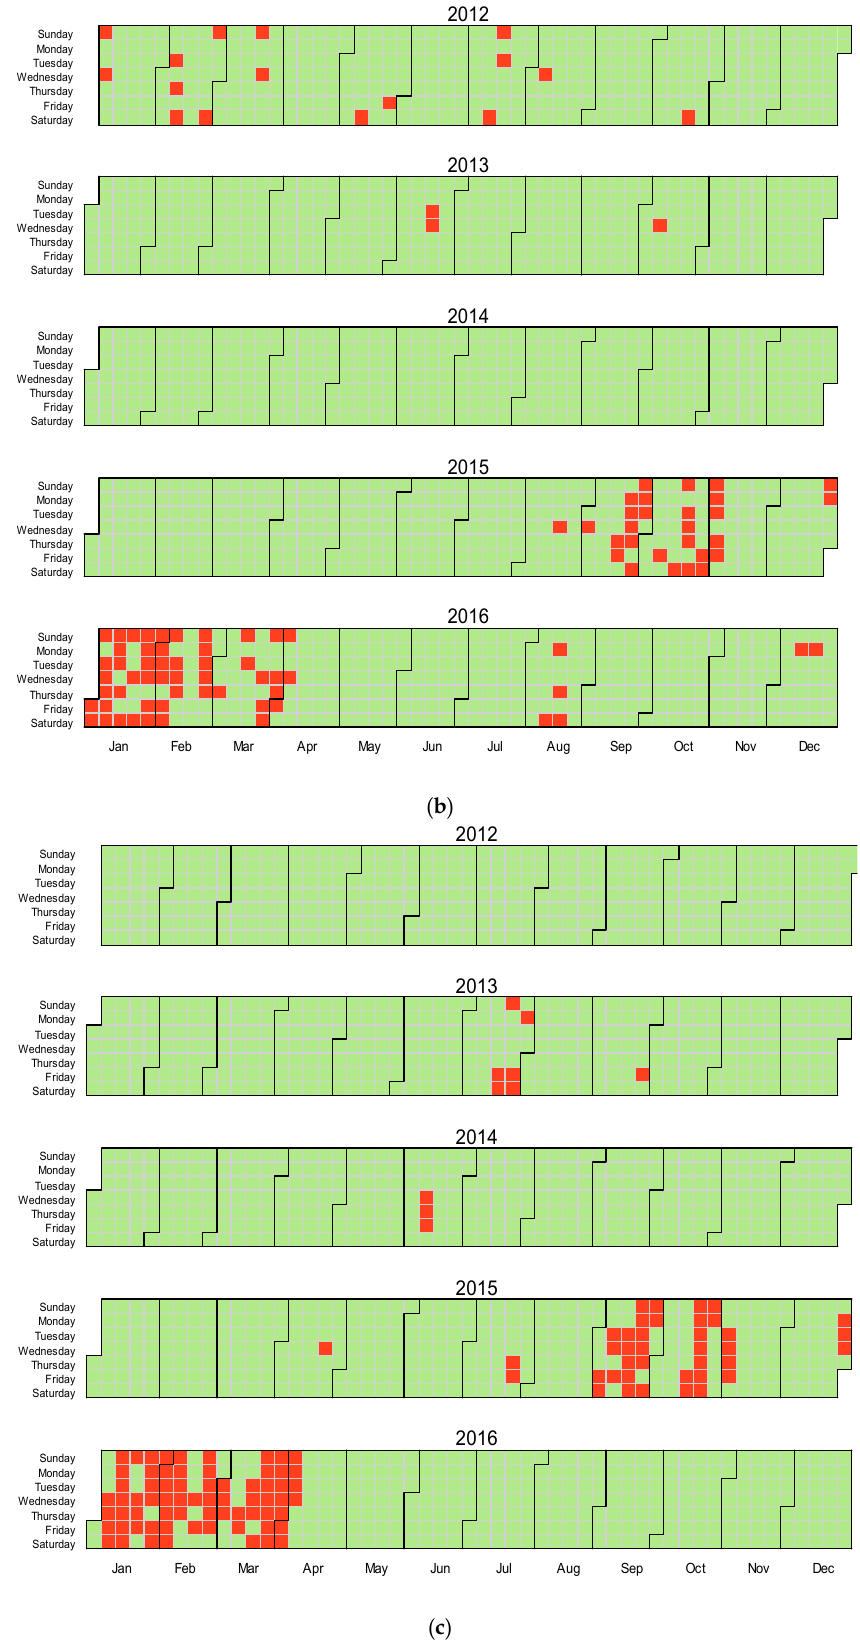
Figure 11. Deficits at Gongju, Gyuam, and Bugang. ( a ) Gongju; ( b ) Gyuam; ( c ) Bugang.